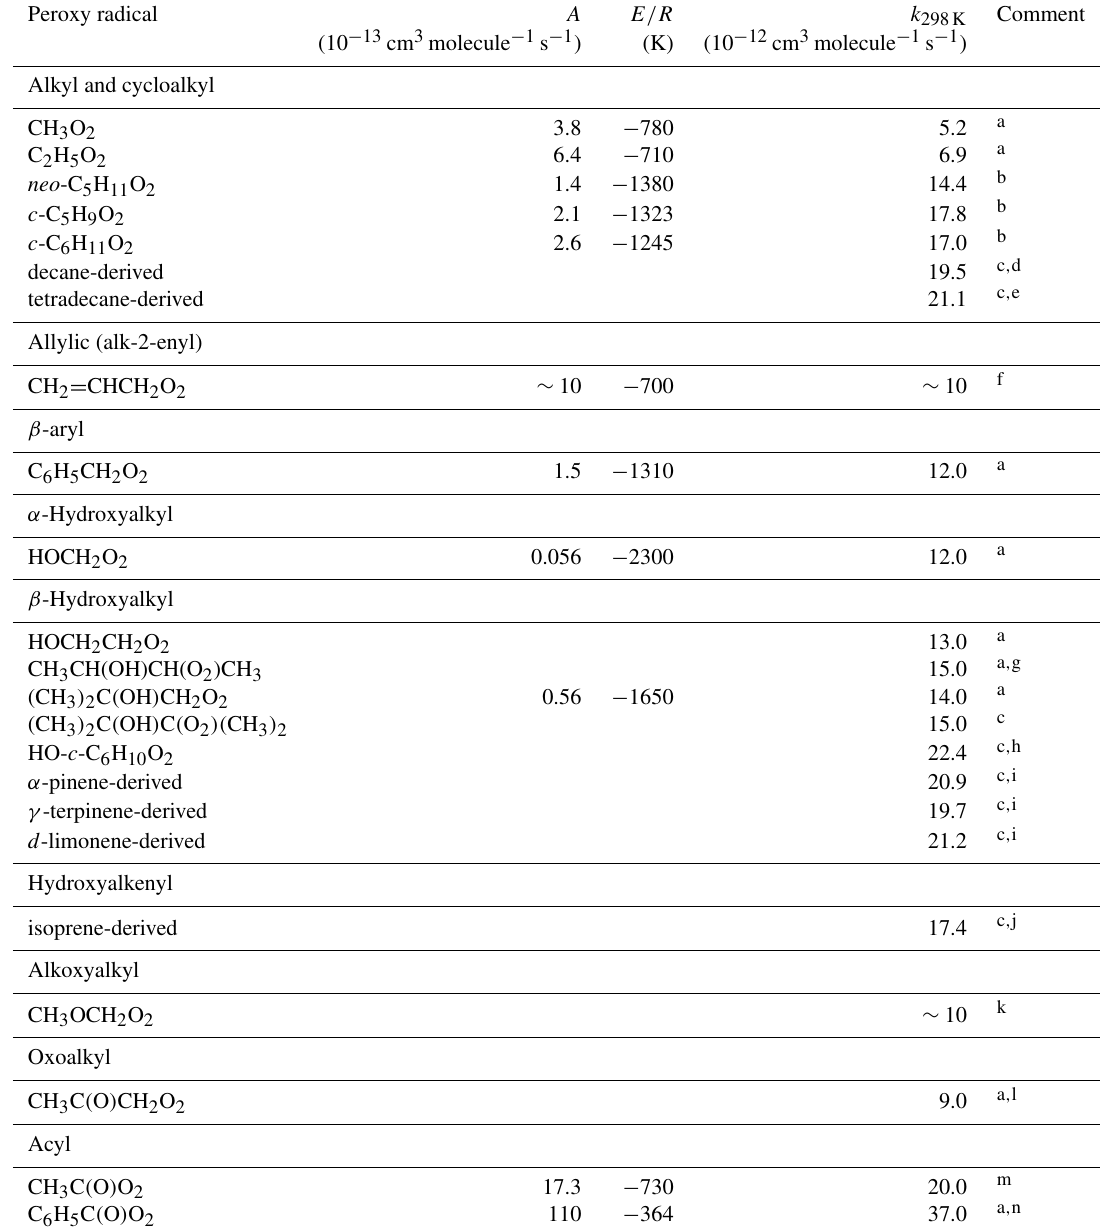
Table 7. Kinetic data for the reactions of hydrocarbon and oxygenated peroxy radicals with HO 2 . Where available, the temperature depen- dence is given by k = A exp ( − E/RT )